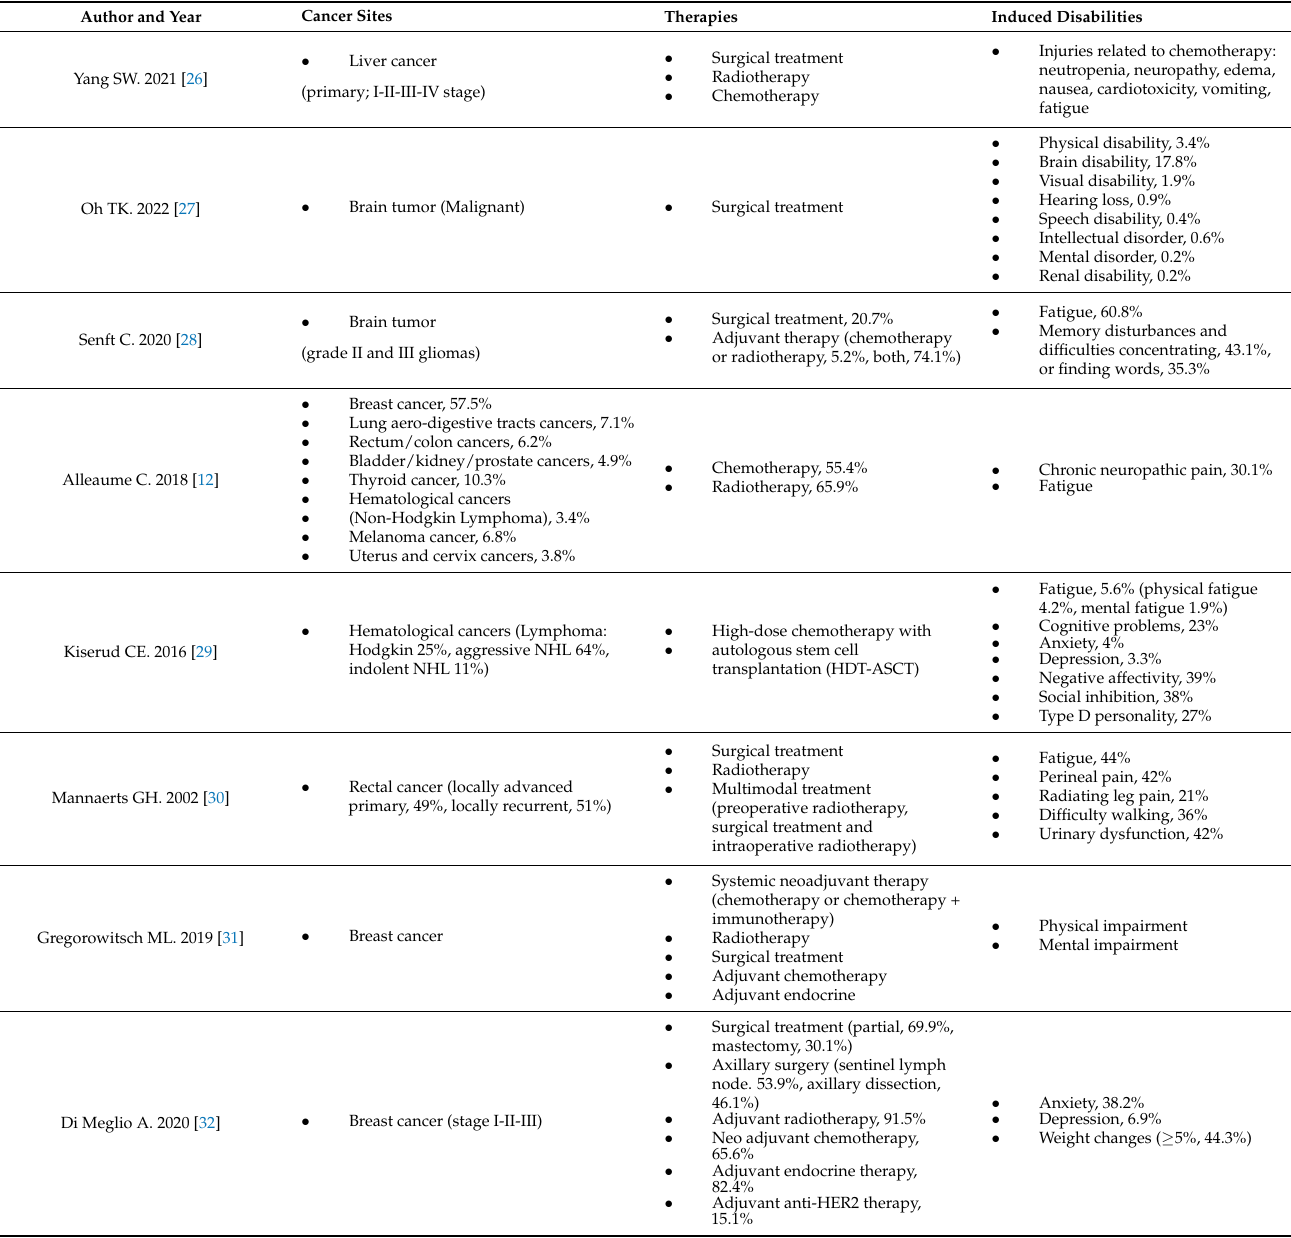
Table 3. Summary table of cancers, therapies and induced